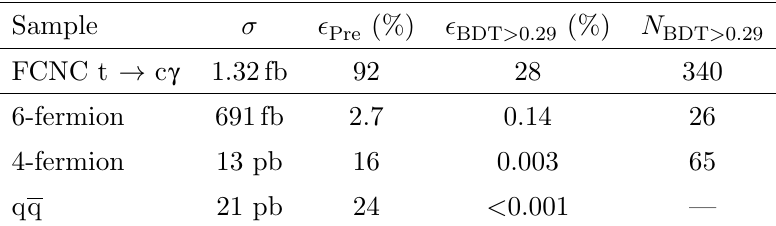
Figure 28. Invariant mass distribution of the top quark from the FCNC decay t ! c g recon- structed at 380 GeV CLIC after selection based on the BDT response. The distribution is normalised to 1.0 ab (cid:0) 1 and BR(t ! c g ) = 10 (cid:0) 3 for the signal events. The hatched histogram indicates the SM background contribution.